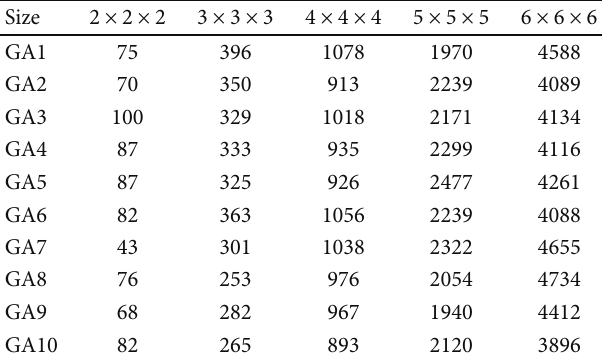
Figure 12: Function of calculation time vs. cube ’ s size. Table 7: Solution lengths with 100 macros.